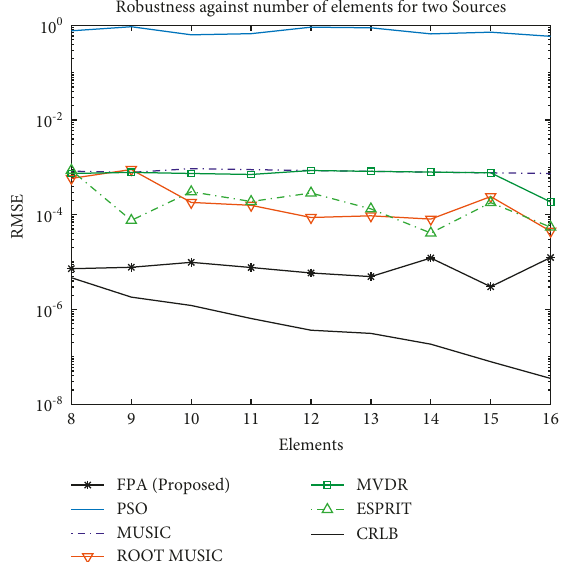
Figure 7: Performance of RMSE vs SNR for two sources.